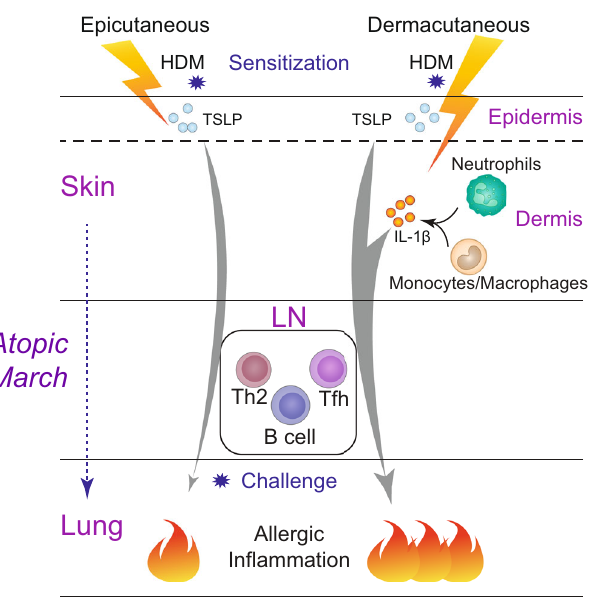
Fig. 8 | A schematic representation of the context-dependent role ofTSLP and IL-1 β in promoting skin allergic sensitization and the atopic march. When allergen HDM sensitization occurs super fi cially in the skin (epicutaneous sensiti- zation), TSLP derived from keratinocytes located in the epidermis plays a dom- inantly crucial role for allergic sensitization through the lymph node (LN; generatingTh2,TfhandBcellresponses)andthesubsequentallergicin fl ammation inthelung.Whenallergensensitizationoccursdeeplyintheskin(dermacutaneous sensitization), IL-1 β derived from the in fi ltrated neutrophils and monocytes/mac- rophages contributes together with TSLP, to generate a stronger allergen sensiti- zation and subsequently a more severe lung allergic in fl